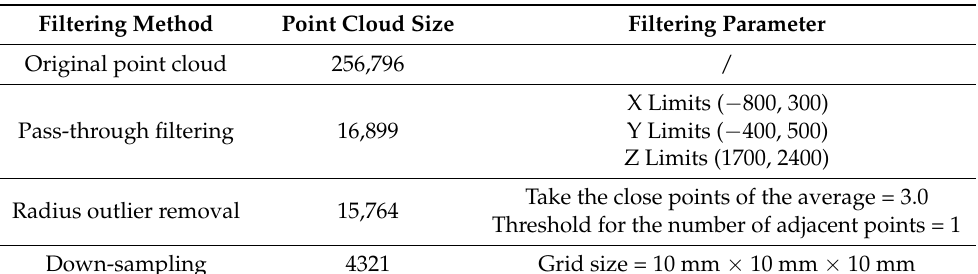
Figure 3. ( a ) Original point cloud captured by the depth camera; ( b ) model point cloud after pass-through filtering; ( c ) model point cloud after radius outlier removal; ( d ) model point cloud after down-sampling. Table 1. Filtering parameters and point cloud scale of each filtering stage.